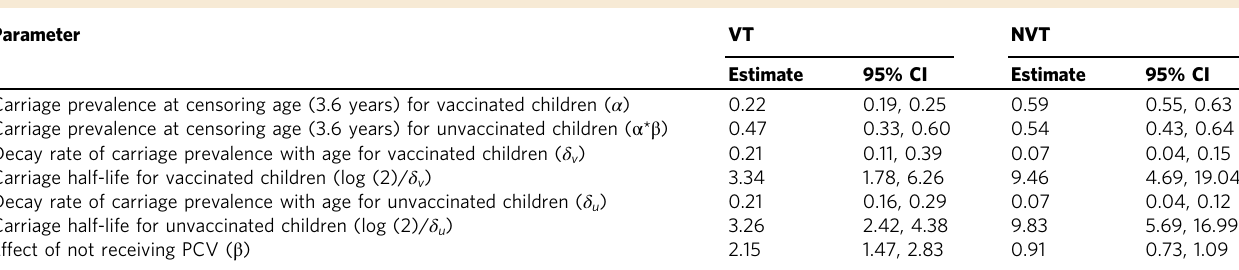
Table 3 Estimates for probability of carriage with age and carriage half-life.